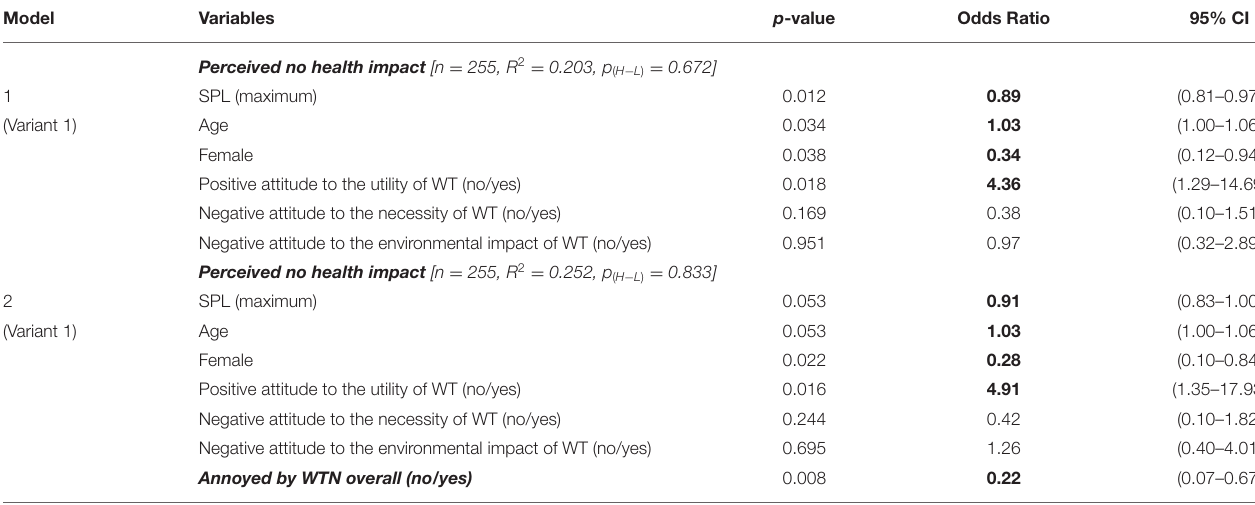
TABLE 4 | Association among no health concerns, sound pressure levels (SPLs), and covariates. Model